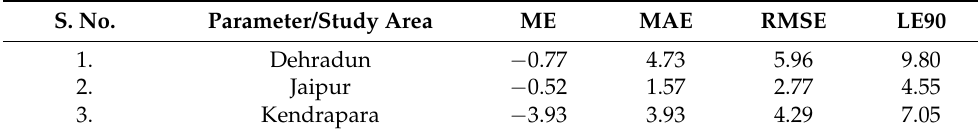
Figure 4. FABDEM for Dehradun site. Table 2. Depicts the statistical parameters of FABDEM at the three